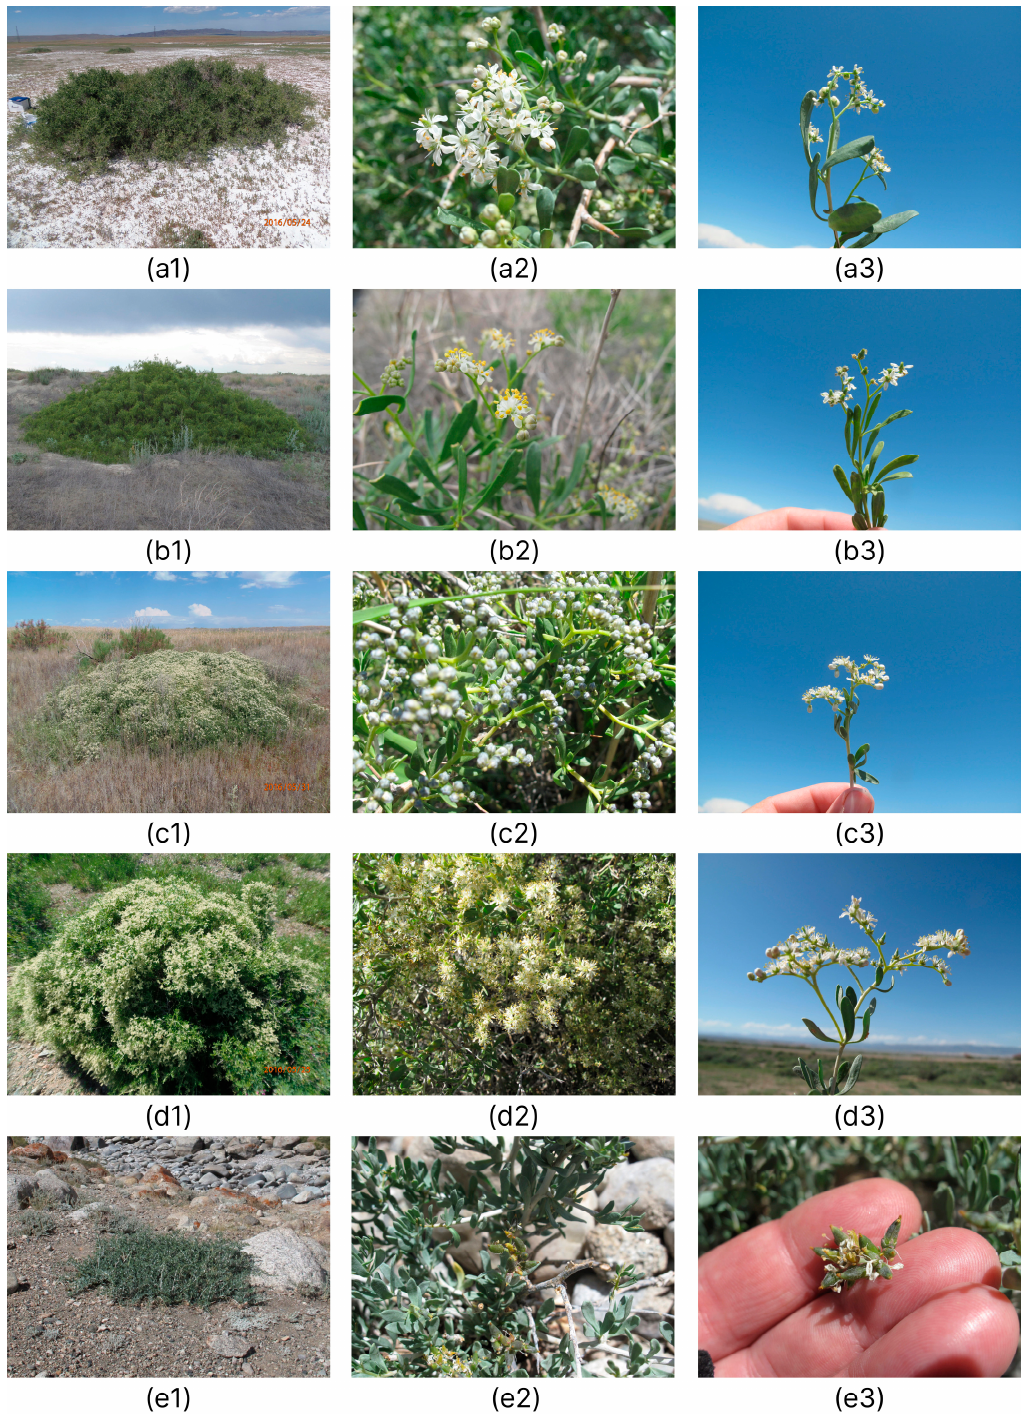
Figure 8. Morphological differences amongst ( a1–a3 ) N. schoberi , ( b1–b3 ) N. komarovii , ( c1–c3 ) N. sibirica , ( d1–d3 ) N. iliensis, and ( e1–e3 ) N. pamirica at the flowering stage, 1—habit, 2—flowers, 3—inflorescence. Photo by Banaev E.V.